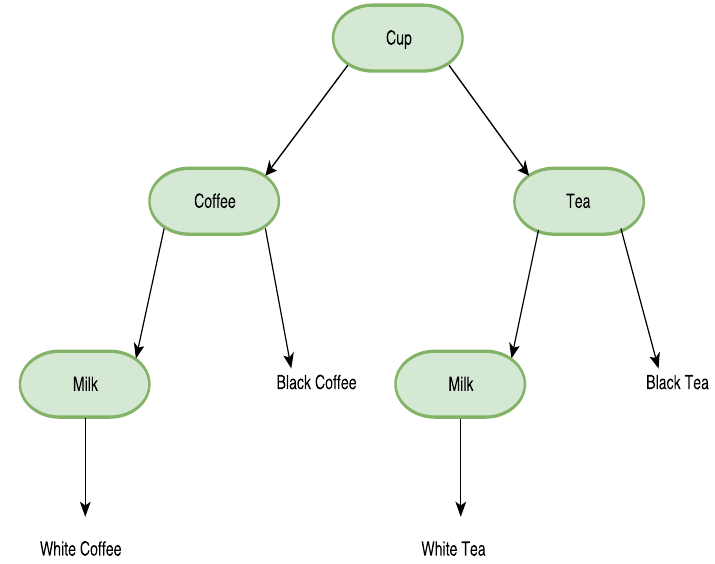
Figure 4. The four kitchen object and the possible resulting activity